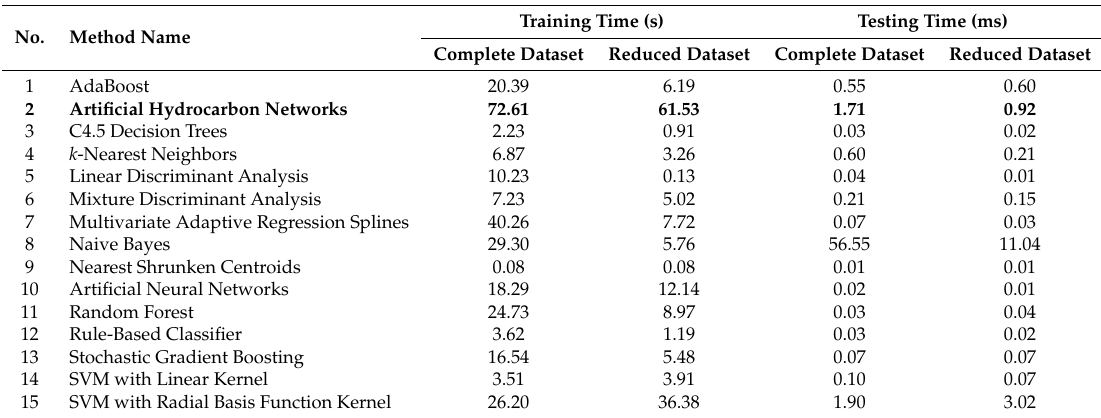
Table 21. Training and testing times of the supervised classifiers in the complete and the reduced